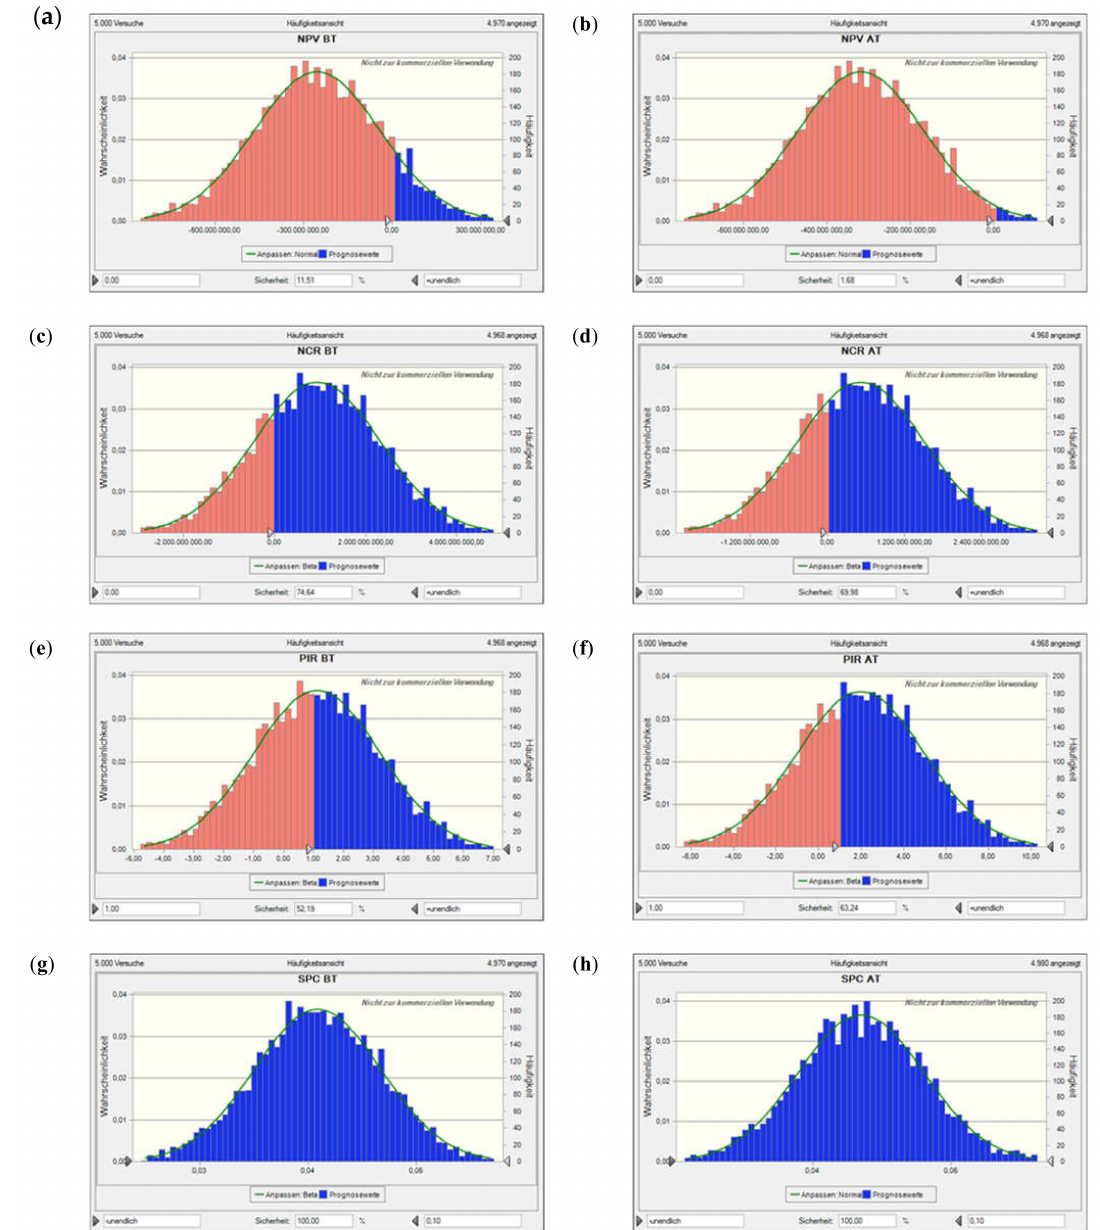
Figure A6. Value at risk for Scen. 2, incl. flooding time, based on a monte Carlo simulation with 5000 runs. Plots ( a ) and ( b ) show the net present value (NPV) before and after tax, plots ( c ) and ( d ) the NCR before and after tax, plots ( e ) and ( f ) the profit-to-investment ratio (PIR) before and after tax, and plots ( g ) and ( h ) the per unit (specific) production costs (SPC) before and after tax. The solid lines denote the fitted probability distribution, the red areas the confidence interval of not encountering a neg. NPV, neg. NCR, or PIR < 1 (i.e., depending on the performance indicator concerned; as the costs considered are all positive, there is only a blue histogram in those two